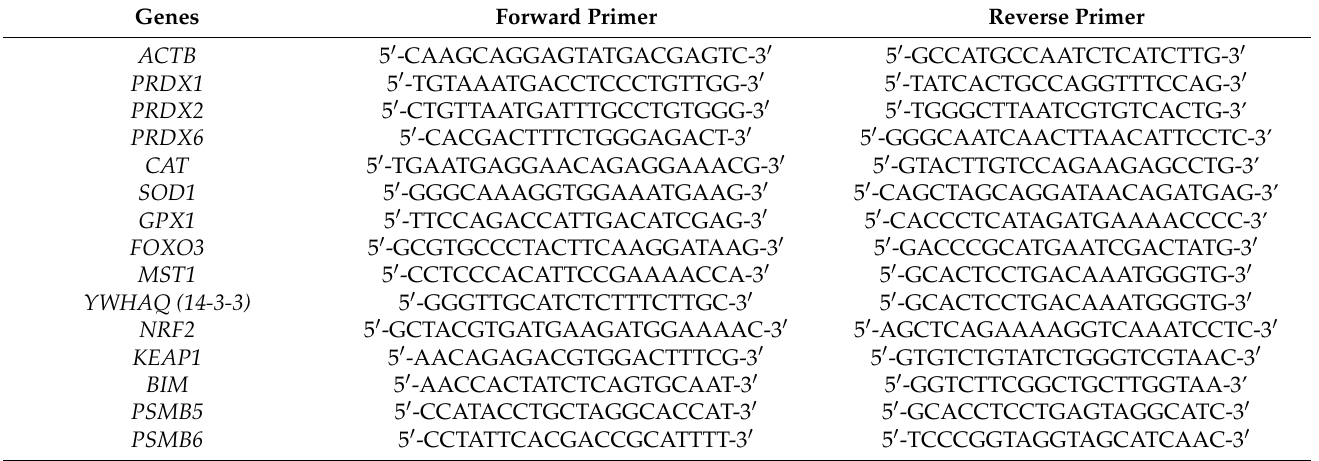
Table 1. Primers sequences.